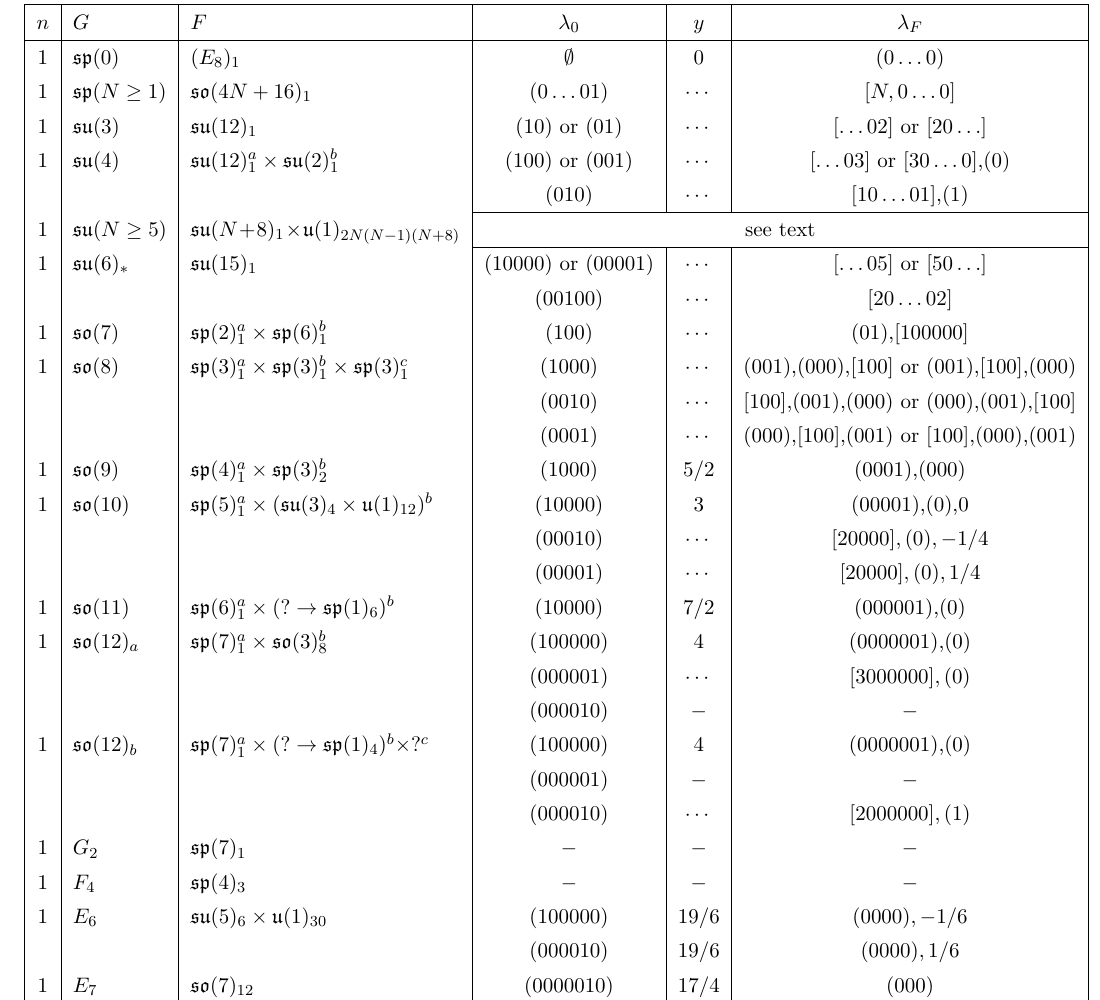
Table 9 . The parameters y, λ F of vanishing blowup equations for rank one models with n = 1 . In the column of λ , the representations are labeled by their highest coweights. When a representation F is composed by many Weyl orbits, we use [ ∗ ] instead of ( ∗ ) to stress the difference. We make assumption for flavor symmetries of the G = so (11) and so (12) models which allow for vanishing b blowup equations; see the main text for more